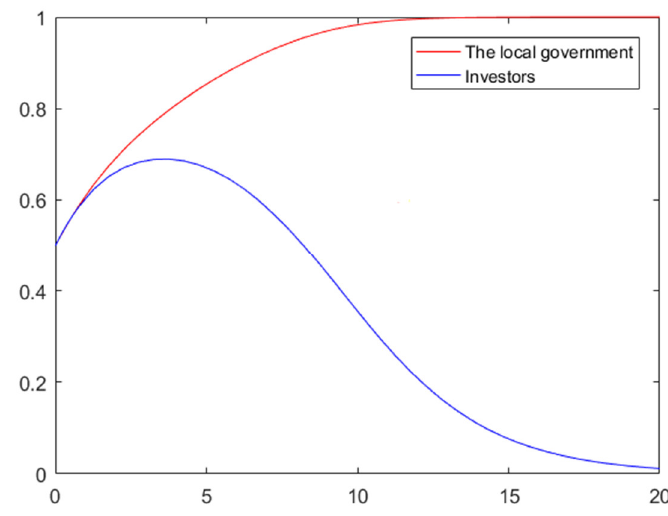
Figure 6. Simulation results in the bubble burst